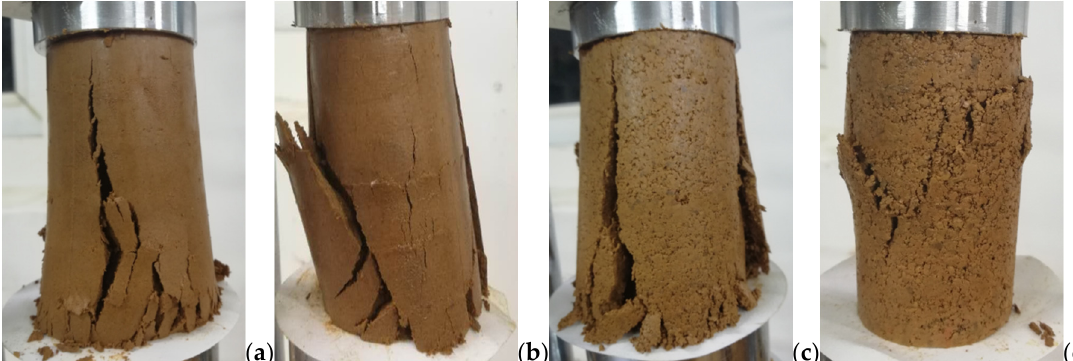
Figure 7. Failure pattern of soil sample: ( a ) 0.25 mm; ( b ) 0.5 mm; ( c ) 2 mm; ( d ) 5 mm. As shown in Figure 8, the UCS tests of red clay under different dry density conditions have obtained stress–strain curves of different particle diameters, which all reveal strain- softening with evident peak strength, and the peak point is on the left. As axial strain increases on the left side of the peak point, the axial stress increases rapidly. The soil mass is undergoing compaction, and the internal pores are gradually reduced. To the right side of the peak point, the axial stress rapidly drops and then slowly decreases. Comparing these with the curves of the red clay of different dry densities, as the dry density increases, the peak point gradually moves to the right along the horizontal axis, indicating that the soil mass has a more extraordinary ability to withstand deformation before failure with the increase in dry density.